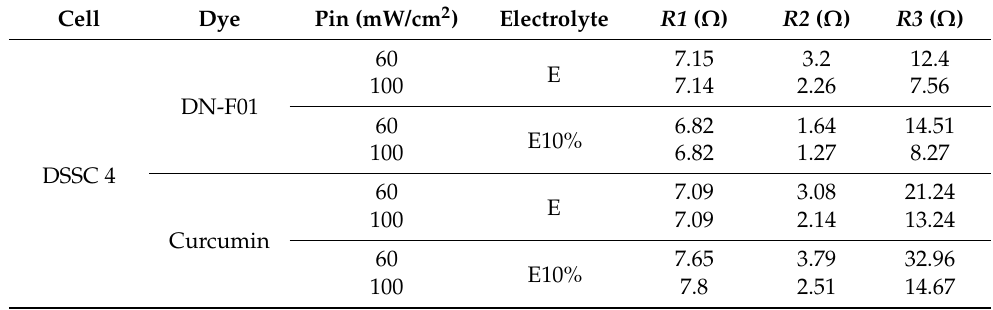
Table 3. EIS parameters obtained from fitting the Nyquist plots of DSSC 4 with and without water content using both DN-F01 and curcumin dye, and under 60 mW/cm 2 and 100 mW/cm 2 of the illumination intensity.